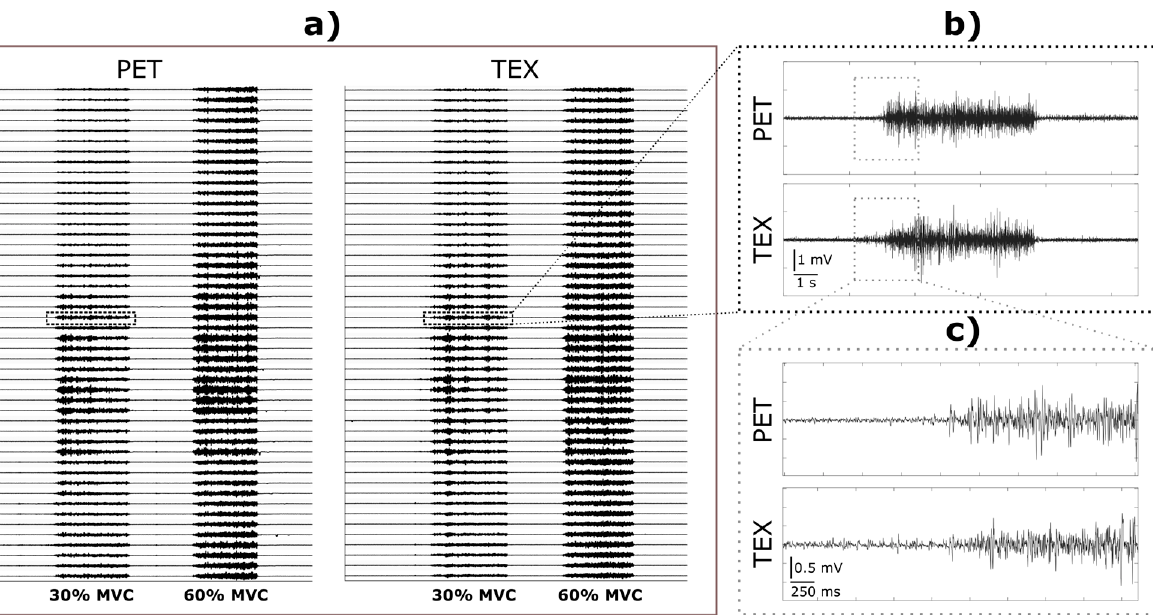
Figure 8. EMG signals from a representative participant recorded while performing a “power grasp” gesture. ( a ) Monopolar signals recorded from 48 channels using PET (left) and TEX (right). The dashed line marks two EMG bursts corresponding to the muscle contractions at 30% MVC from a selected representative channel. ( b ) The two selected contractions recorded by PET (top) and TEX (bottom). ( c ) The initial phases of the two selected contractions recorded using PET (top) and TEX (bottom).